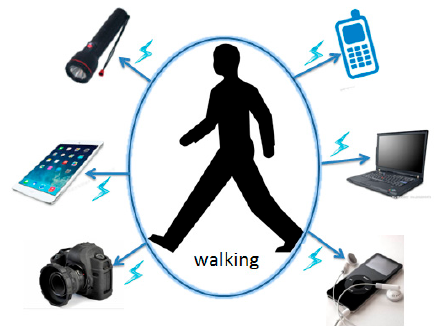
Figure 9. Typical utilizations of harvested human walking induced energy.